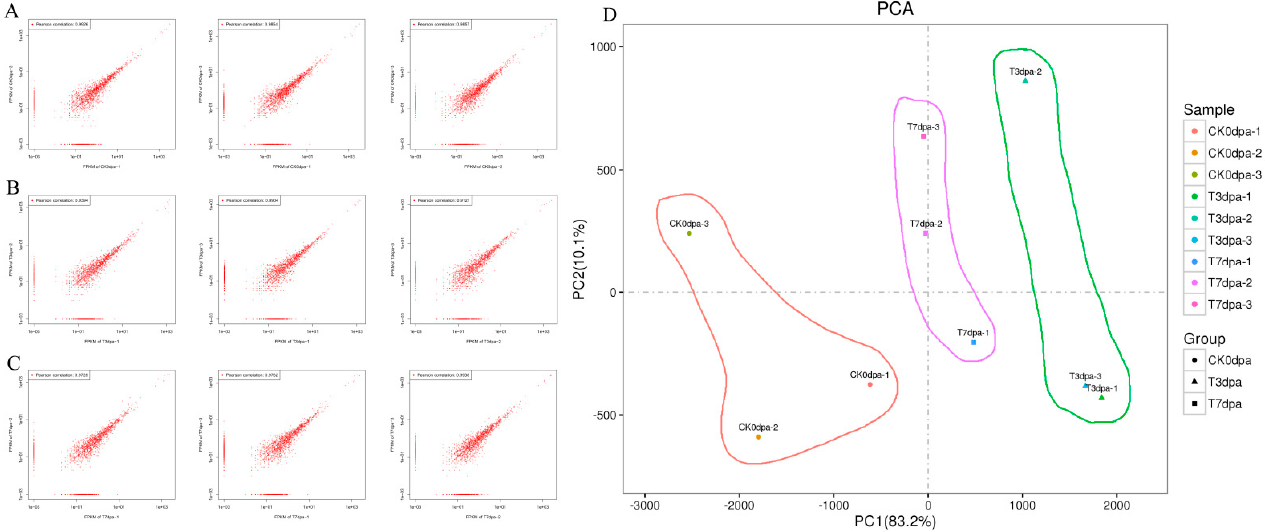
Figure 2. Quality analysis on the transcriptome sequencing. ( A – C ) The correlation coefficients of the paired repeatability test. The closer the correlation between two parallel experiments of the same sample was to 1, the higher the repeatability. CK0dpa, control group at 0 days post-amputation; T3dpa and T7dpa, caudal fin regeneration at 3 and 7 days post-amputation, respectively. ( D ) The principal component analysis (PCA) for each sample. CK0dpa, control group at 0 days post-amputation; T3dpa and T7dpa, caudal fin regeneration at 3 and 7 days post-amputation, respectively.